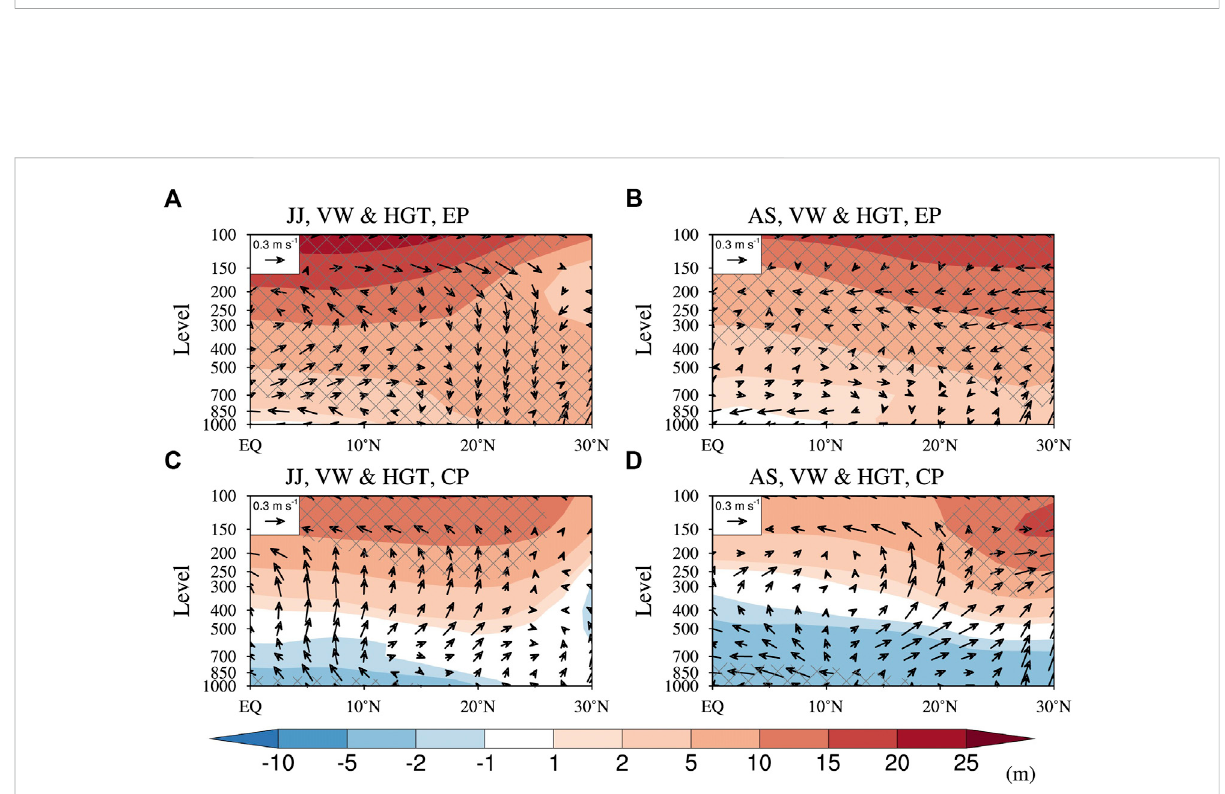
FIGURE 5 (A) June – July (JJ) and (B) August – September (AS) for the meridional circulation (vectors; units: m s − 1 ) and geopotential height (shading; units: m) anomalies averaged from 65 to 85 ° for decaying eastern Paci fi c (EP) El Niño events. (C) and (D) are the same as (A) and (B) , but for CP El Niño events. The vertical pressure velocity is multiplied by a factor of − 50 for clarity. Gray crosses indicate geopotential height anomalies above the 80% signi fi cance